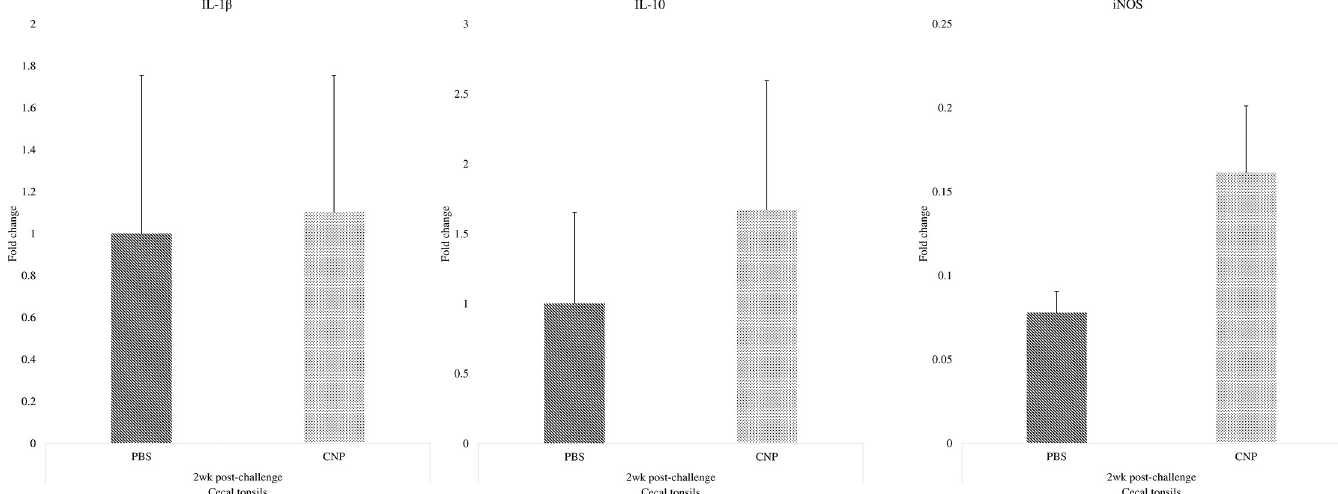
Fig 6. Cytokine gene expression in the cecal tonsils of chickens vaccinated in-ovo with CNP. At embryonic d18, broiler eggs were vaccinated with either PBS (control) or 1000 μ g CNP vaccine. At d7 of age, birds were challenged with live SE (1.0 × 10 9 CFU/bird). Cecal tonsil samples were collected at 2wk post-challenge and analyzed for cytokine mRNA amounts by RT-PCR. Data represented fold change compared to control. A–IL-1 β mRNA; B–IL-10 mRNA; C–iNOS mRNA. Data analyzed by parametric Student t-test; Means+SEM.Bars. n = 6. " � " means P < 0.05.